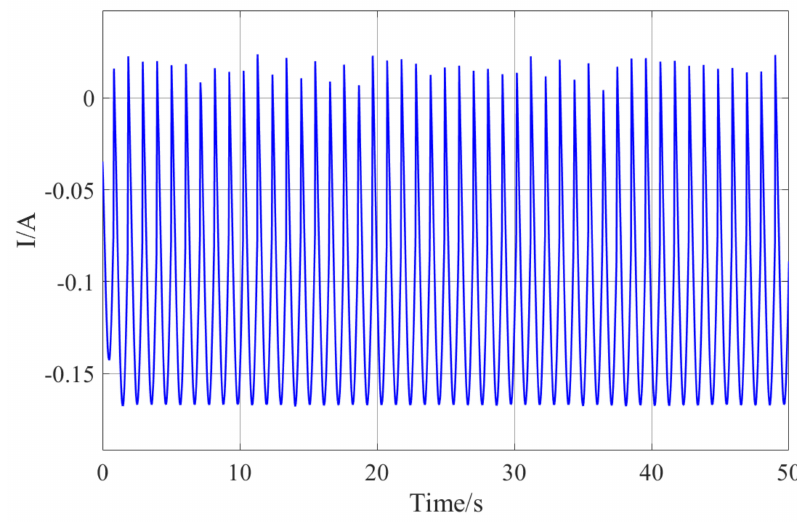
Figure 14. The current of the MRD under low-frequency sinusoidal excitation.